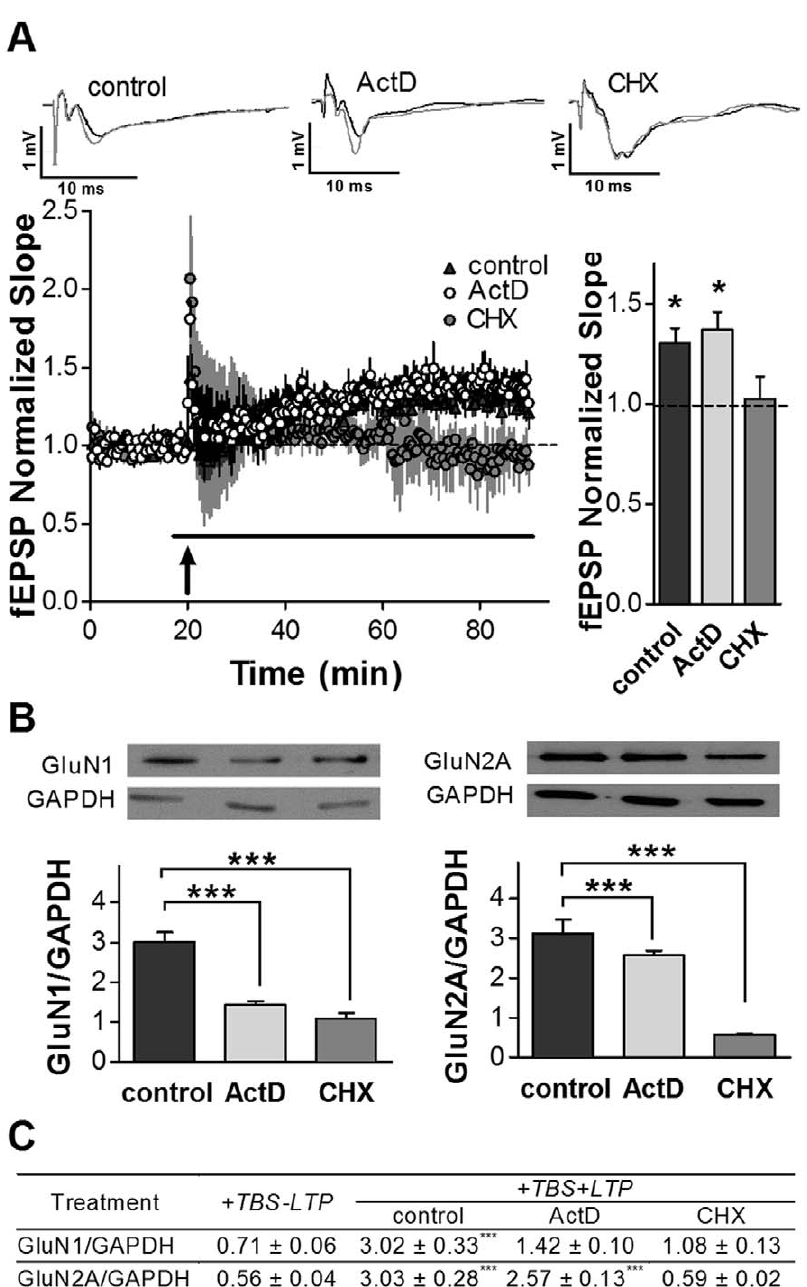
Figure 4. NMDAR subunits modification in hippocampal slices after transcription or translation inhibition during LTP induction. A. Left: Normalized slopes of evoked fEPSPs recorded as those in Figure 3, corresponding to the first pulse of the paired stimulation applied before and after TBS (arrow). Plots represent the average of five independent experiments over 90 minutes of recording (n=5 for each group). Black line : drug perfusion. Insert on top : average traces of 10 individual recordings from a control slice and slices treated with ActD or CHX (black: 5 minutes before TBS; grey: 5 last minutes of recording). Right: Bars represent averages of normalized first pulse slopes of the 5 last minutes of recording for each group. LTP induction was blocked by 40 m g/ml CHX treatment (* p , 0.05, one sample t test) compared to basal transmission (line referred to 1 in the graph). B. NMDAR subunits were evaluated by WB in same slices that in A. CHX treatment blocked GluN1 and GluN2A increase, while 50 m g/ml ActD only blocked GluN1 increase (* p , 0,05 ONE WAY ANOVA, Dunnet Post-Test; n=5 for each group). Insert on top: (from left to right): Representative GluN1 and GluN2A WB bands of + TBS + LTP slices (control), CHX and ActD + TBS + LTP slices treated slices. C. Table indicates mean 6 SEM for GluN1/ GAPDH (first row) or GluN2A/GAPDH (second row) in + TBS-LTP slices (n=6) and + TBS + LTP slices without any drug treatment (Control in B, n=9), or treated with ActD (n=5) or CHX (n=5) (*** p , 0.0001; ONE WAY ANOVA - Newman Keuls Test).